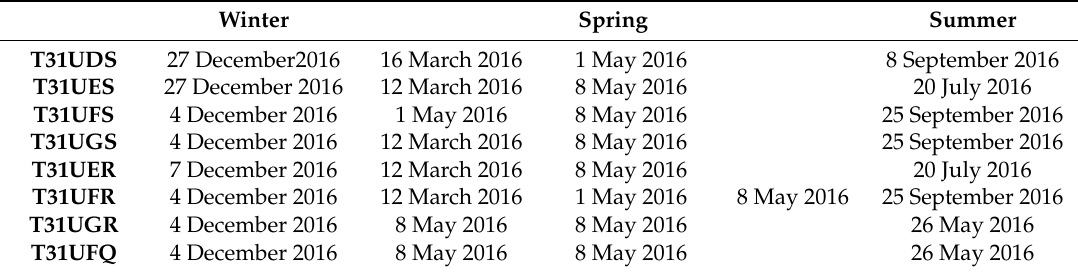
Table 1. The dates of the images used to produce the three mosaics (winter, spring, and summer 2016). Winter